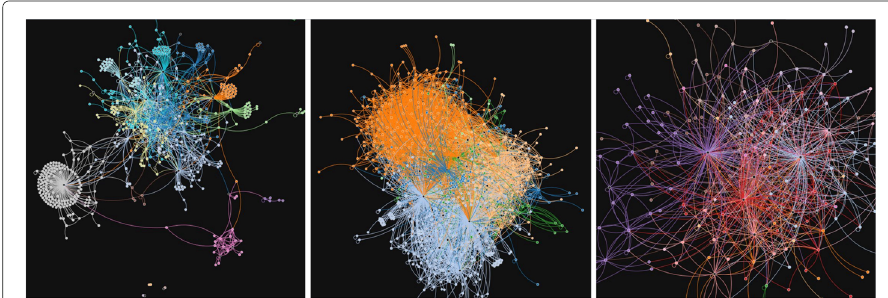
Fig. 1 Interaction networks of three small online communities. Innovatori PA ( left ) does not have an onboarding policy in place, whereas the two others do (Edgeryders: center , Matera: right )